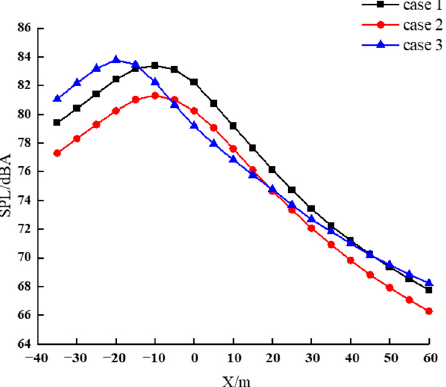
Figure 12. Sound pressure level of the monitoring point along the x-direction.